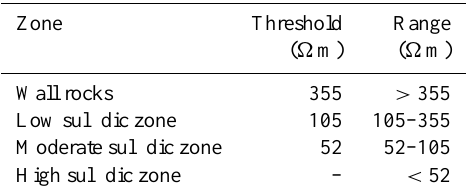
Table 2. Threshold values obtained by using the C - V method based on resistivity ( (cid:127) m) in Nowchun deposit.